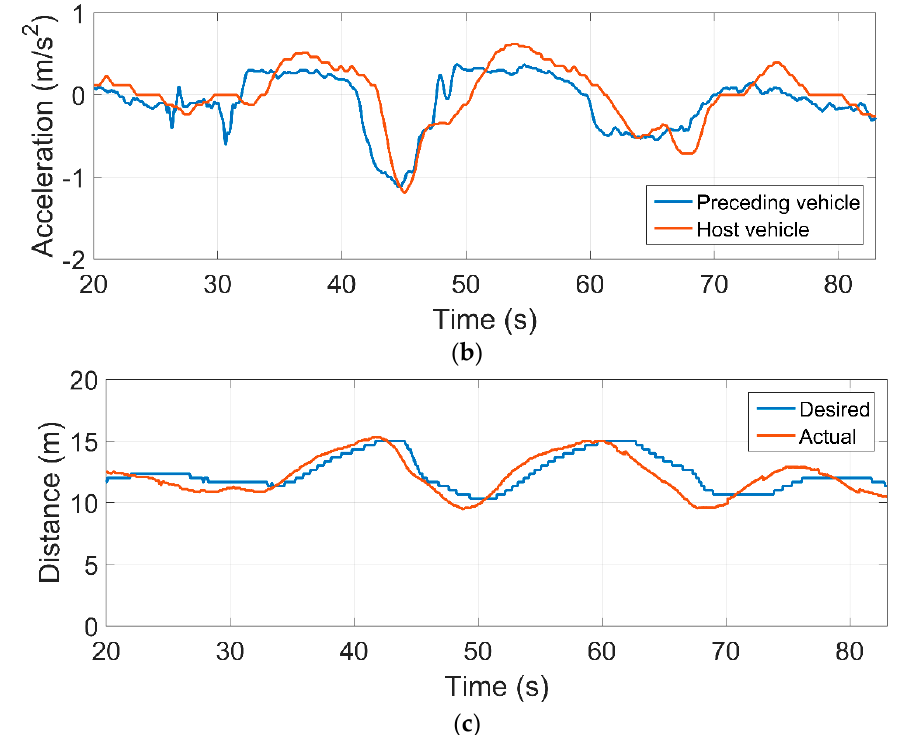
Figure 12. Test results with a 1.2-s time headway: ( a ) velocity, ( b ) acceleration, and ( c ) distance.